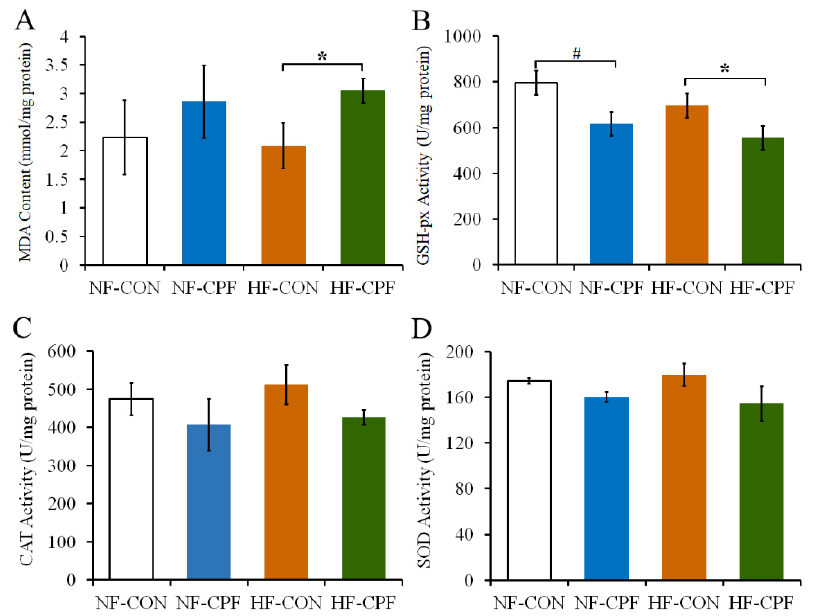
Figure 6. Effects of CPF on the antioxidant system of the liver. ( A ) MDA content. ( B ) GSH-px activity. ( C ) CAT activity. ( D ) SOD activity. CPF—Chlorpyrifos. NF-CON—fed a normal-fat diet and vehicle. NF-CPF—fed a normal-fat diet and chlorpyrifos. HF-CON—fed a high-fat diet and vehicle. HF-CPF—fed a high-fat diet and chlorpyrifos. The symbol * and # indicates a significant difference between the covered groups at p < 0.05.